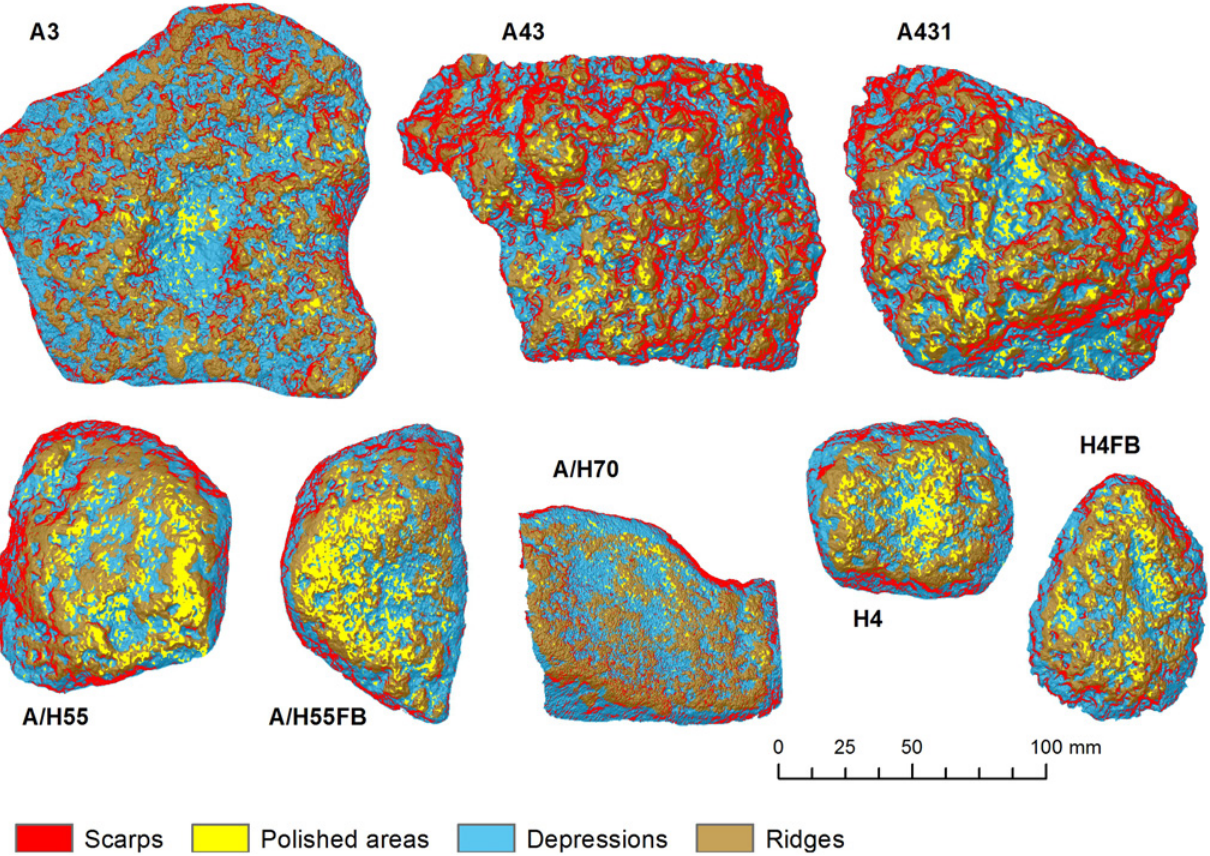
Fig 6. Morphometric classification of the artifacts, based on slope, roughness and TPI results. Identified morphometric features in this classification include ridges and depressions, polished areas (values of the roughness final model < 0.01), and scarps (slope > 45 º